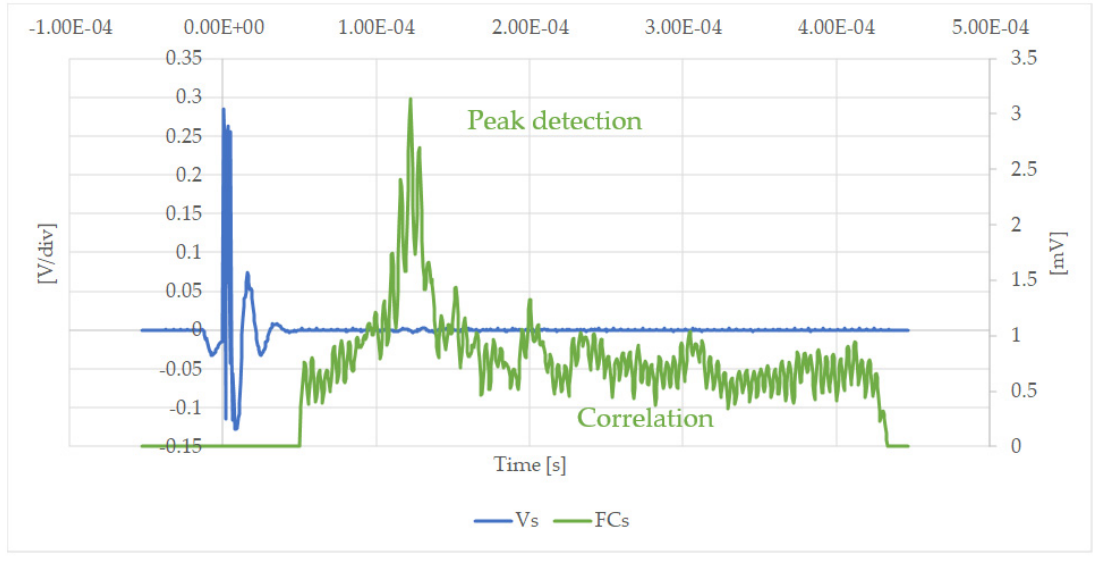
Figure 22. New sensor results: Experimental signal in the receiver, Vs [V], and filtered signal, FCs [mV] after using the correlation filter with a partial cement blockage in position B-2.